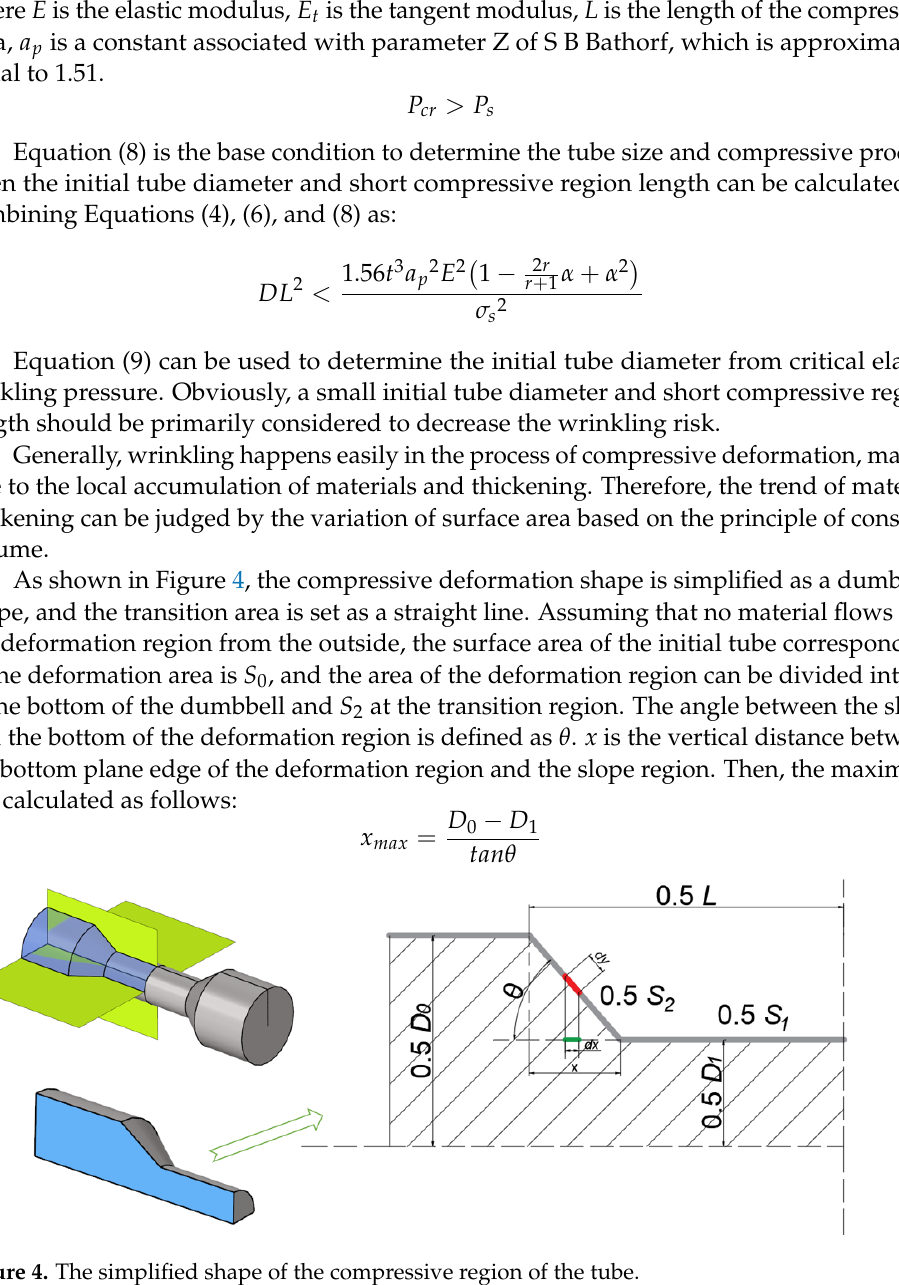
Figure 4. The simplified shape of the compressive region of the tube.